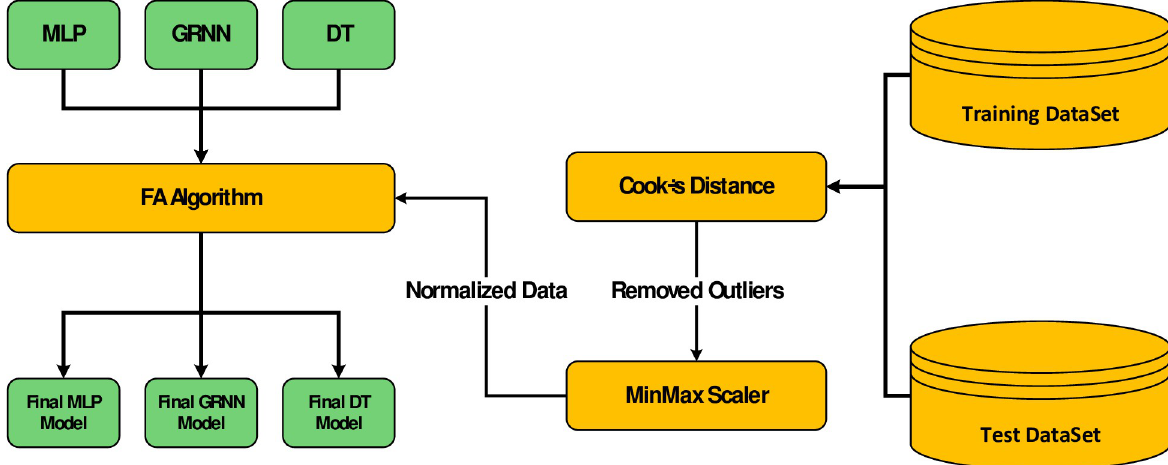
Fig 1. Methodology framework for correlation of crude oil viscosity.